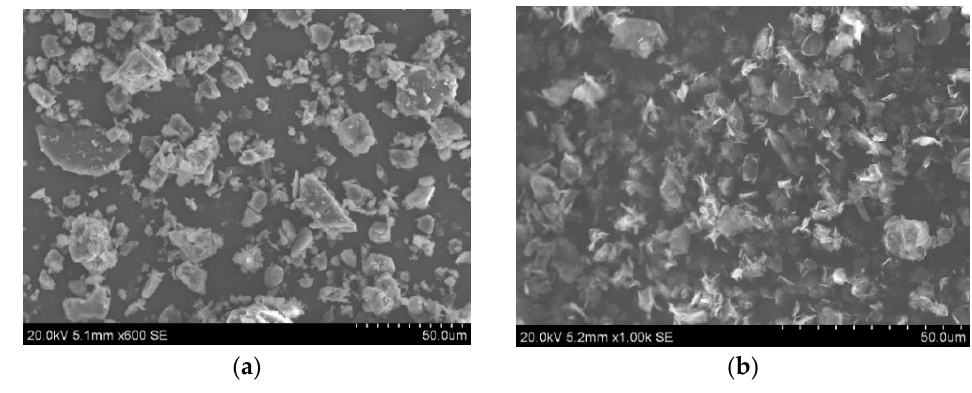
Figure 1. SEM images of ( a ) ATH and ( b ) graphene nanoplatelets.